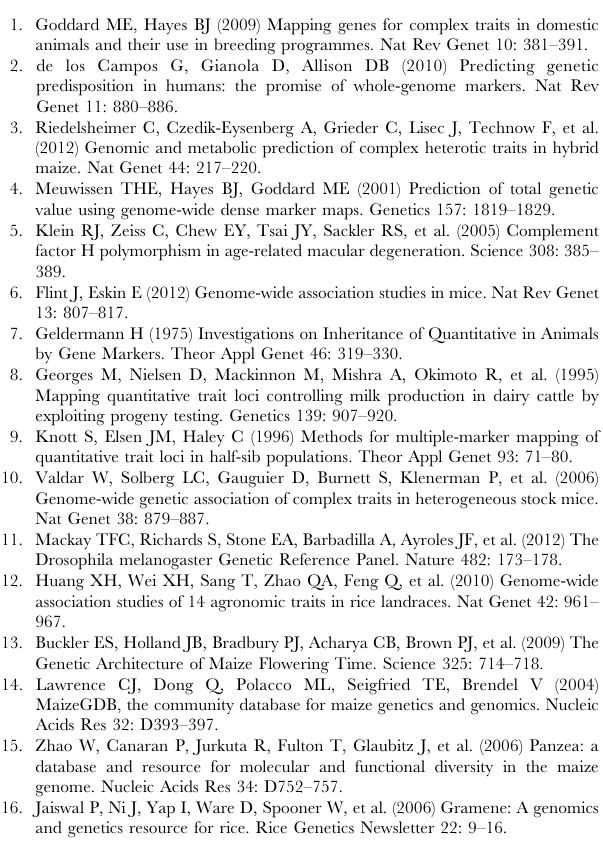
Table S1 Accuracy and unbiasedness for traits with low heritability and small population sizes (based on the dairy cattle data set). The best result in each block is printed in boldface. Table S2 SNP lists for the dairy cattle data set. This table (excel format) includes the name, chromosome, physical position, trait associated, number of QTL reports, and other important information for each SNP used in this study. Table S3 SNP lists for rice diversity panel. This table (excel format) includes the name, chromosome, physical position, trait associated, QTL report, and other information for each SNP used in this